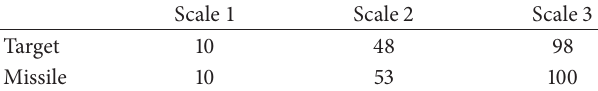
Table 9: The values of Scale 1 , Scale 2 , and Scale 3